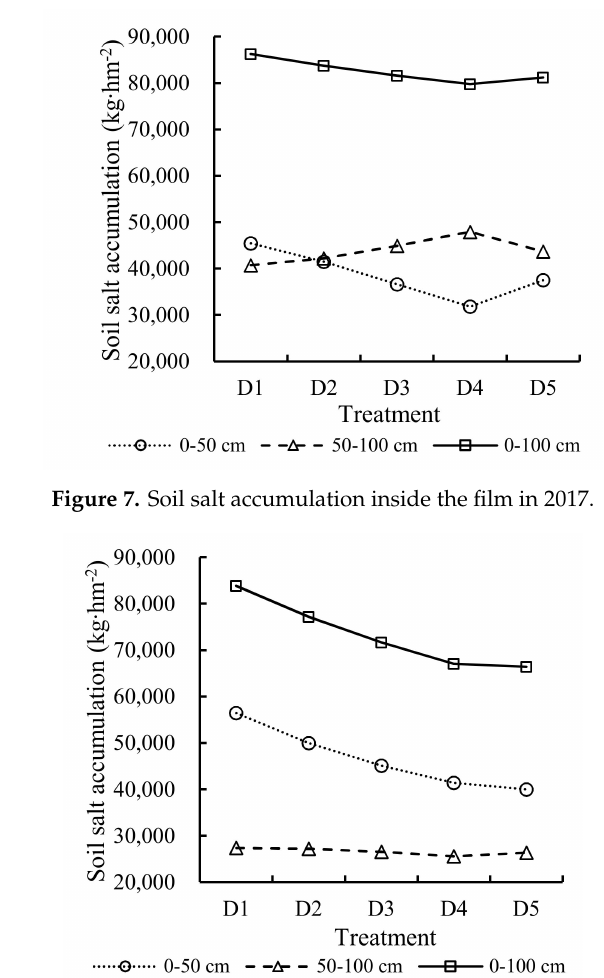
Figure 8. Soil salt accumulation outside the film in